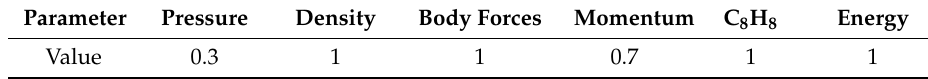
Table 4. Under-relaxation